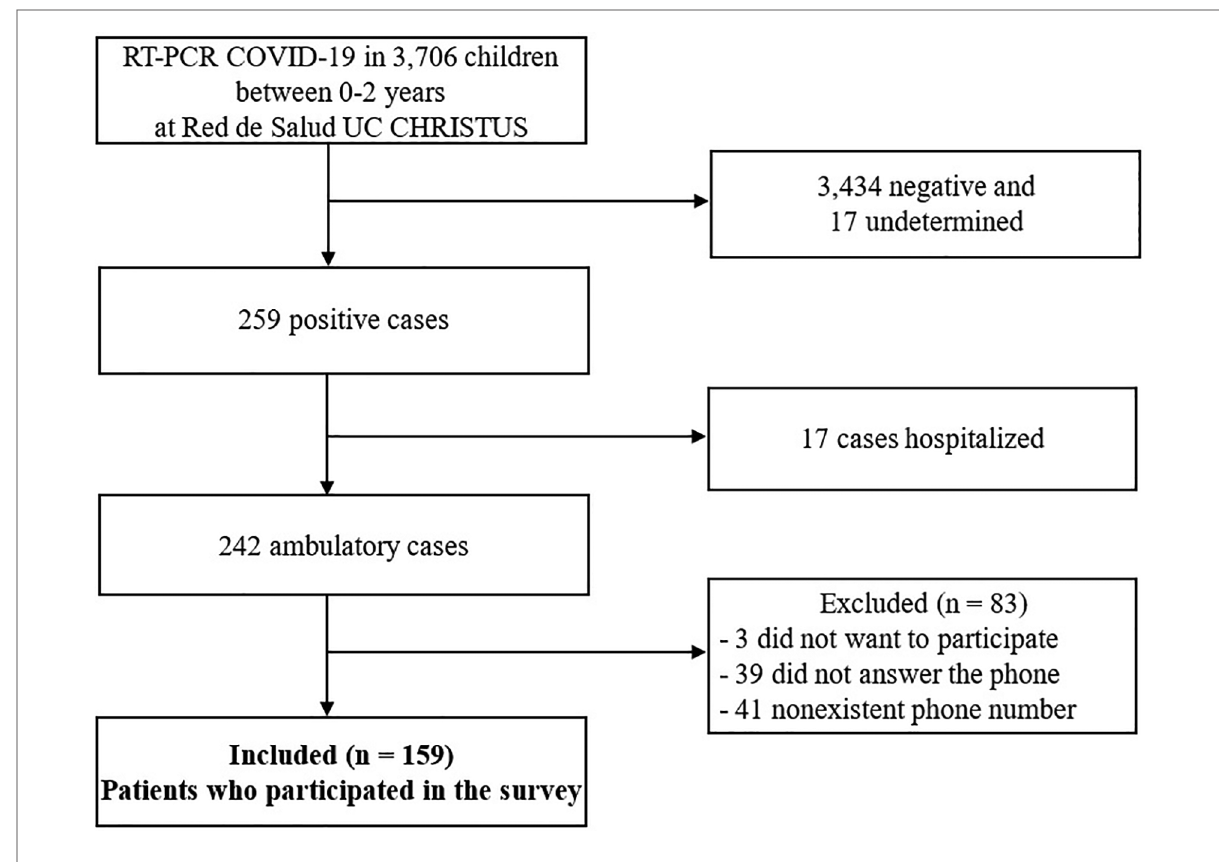
FIGURE 1 Flow chart of the study.